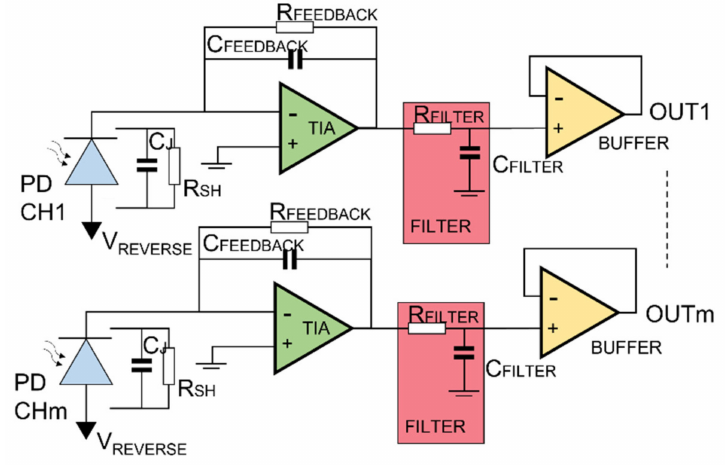
Figure 4. Schematic of the electronic module: representation of a module employing AWG channel from 1 to m to interrogate a single FOS.